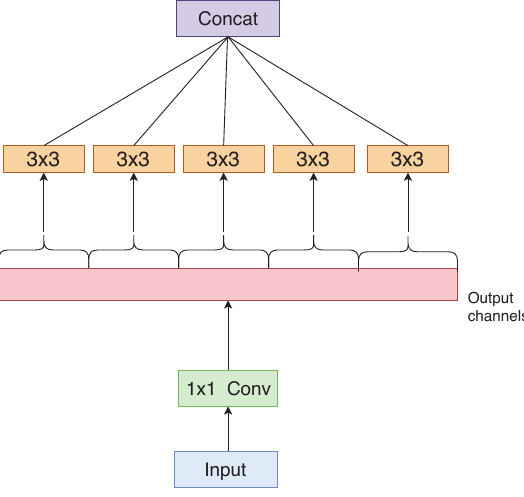
Figure 3. An “extreme” version of our Inception module, with one spatial convolution per output channel of the 1 × 1 convolution [19].